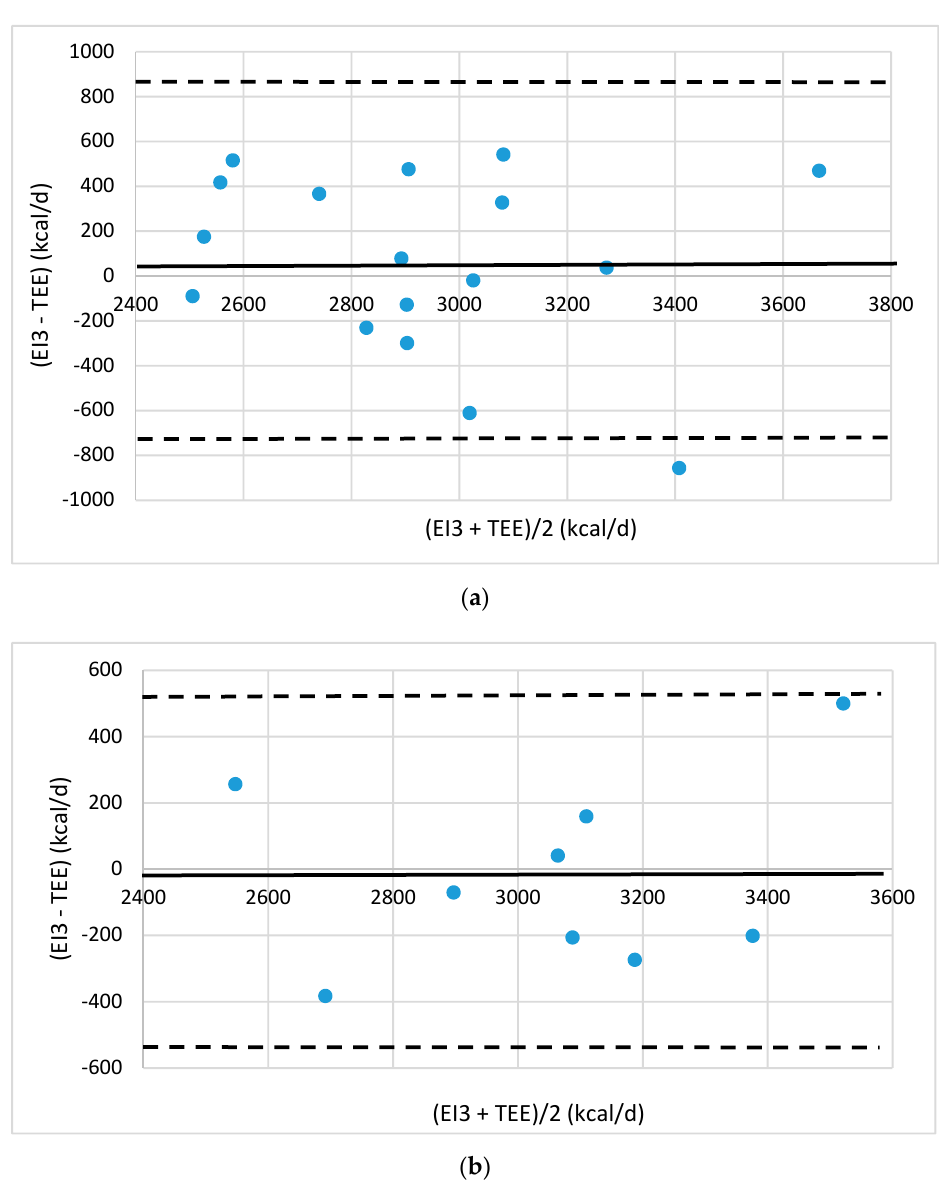
Figure 3. Bland – Altman plots of the agreement level between total energy expenditure (TEE) meas- Figure 3. Bland–Altman plots of the agreement level between total energy expenditure (TEE) measured by eMouve, and ured by eMouve, and energy intake (EI3) estimated by NutriQuantic in overweight-weight men ( a ) energy intake (EI3) estimated by NutriQuantic in overweight-weight men ( a ) in the training group and ( b ) in the test group. in the training group and ( b ) in the test group. Bias is represented as mean difference (two standard Bias is represented as mean difference (two standard deviations).